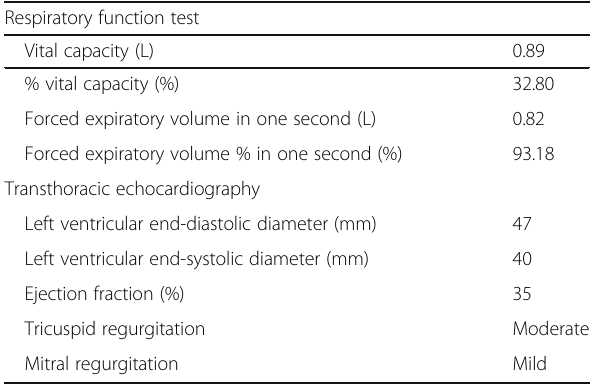
Table 1 Prehospital respiratory function test and transthoracic echocardiography results